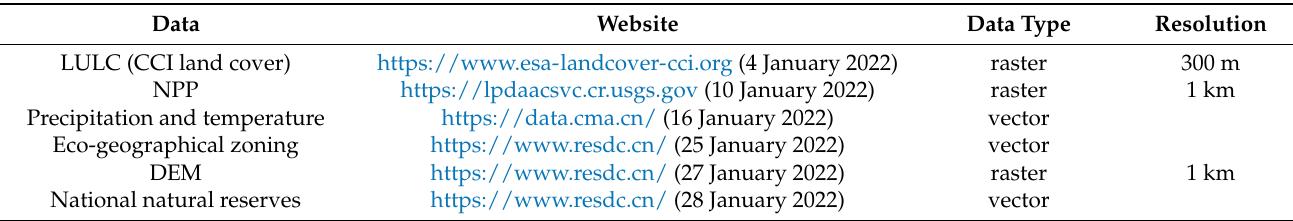
Figure 2. Eco-geographical zoning data in China. Table 1. Data sources.